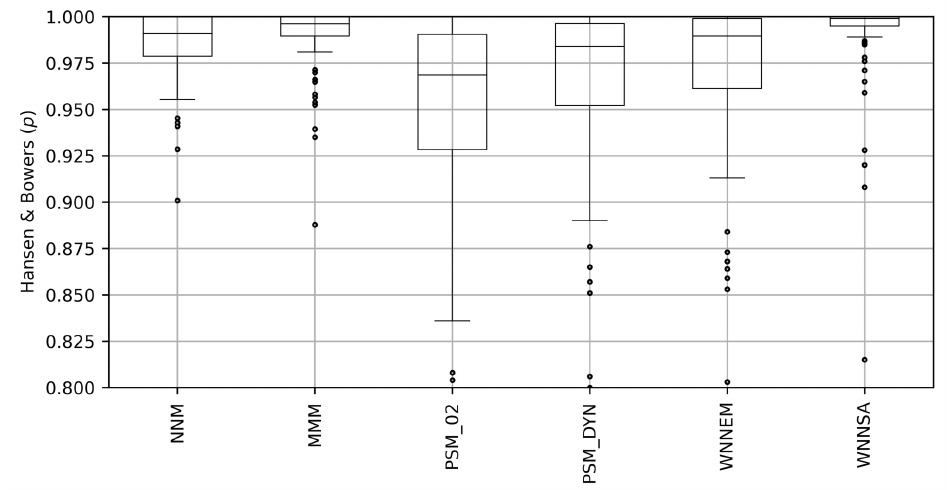
Figure 6. Results of Hansen and Bowers tests in Scenario II. Comparison of the p -values of the Hansen and Bowers test in case of the nearest neighbour matching (NNM), Mahalanobis metric matching (MMM), two types of PSM methods (PSM_02, PSM_DYN), the WNNEM method, and the WNNSA method for the 100 datasets in Scenario